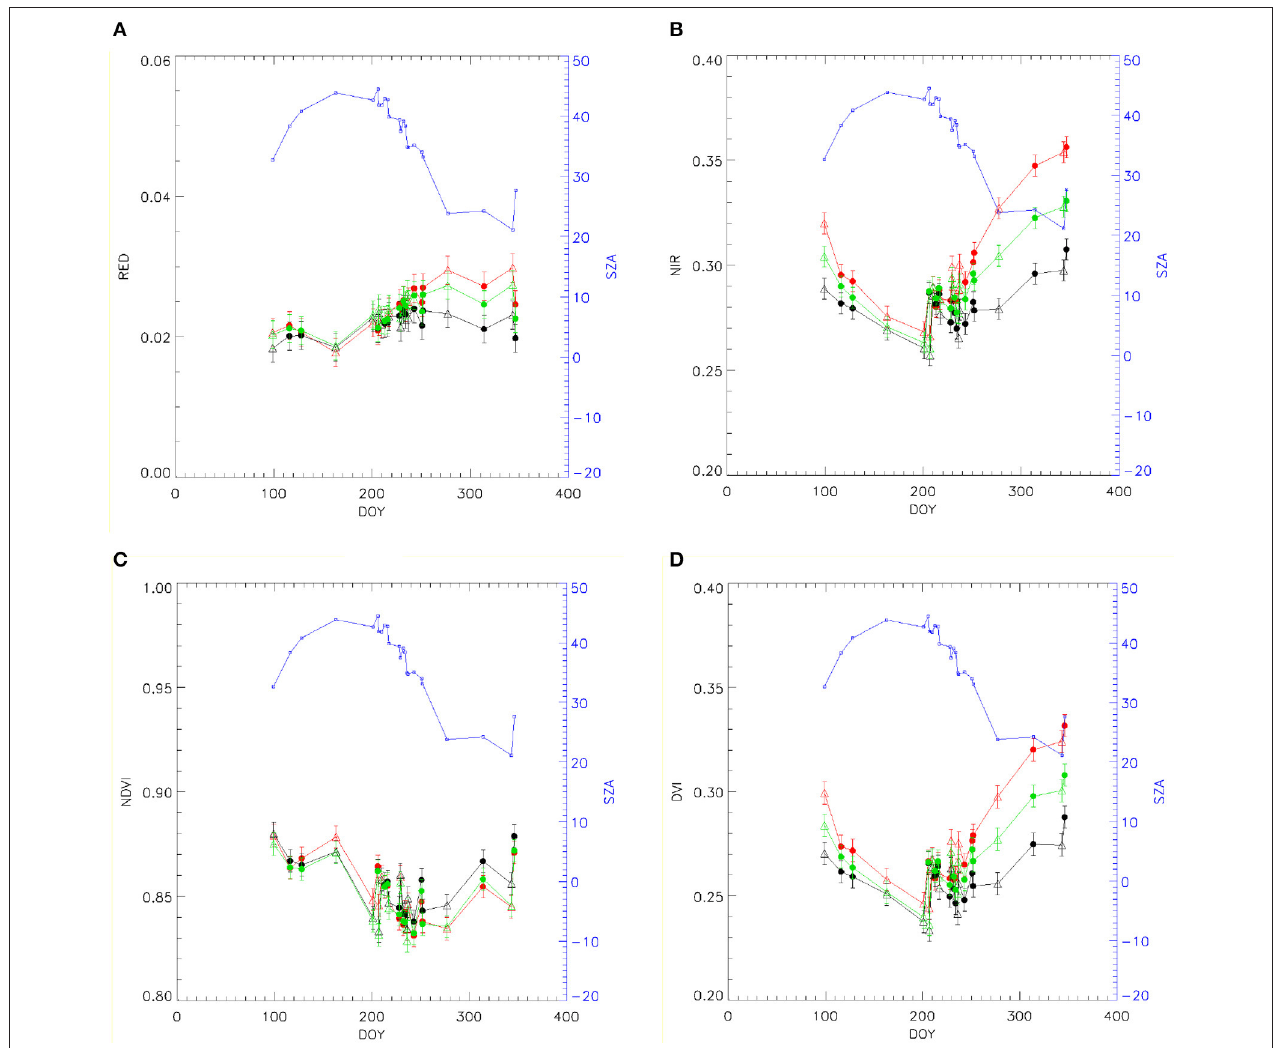
FIGURE 1 | Landsat 8 (dots) and Sentinel 2 (triangles) surface reflectance in the NIR (A) and RED (B) , NDVI (C) and DVI (D) with no normalization (red), HLS BRDF normalization (green) and BRDF-normalized (black). The error bars displayed represent the uncertainty of the Landsat 8 surface reflectance product ( Vermote et al., 2016), assuming the same error for Sentinel 2. The solar zenith angle (SZA) is displayed in blue in the secondary y